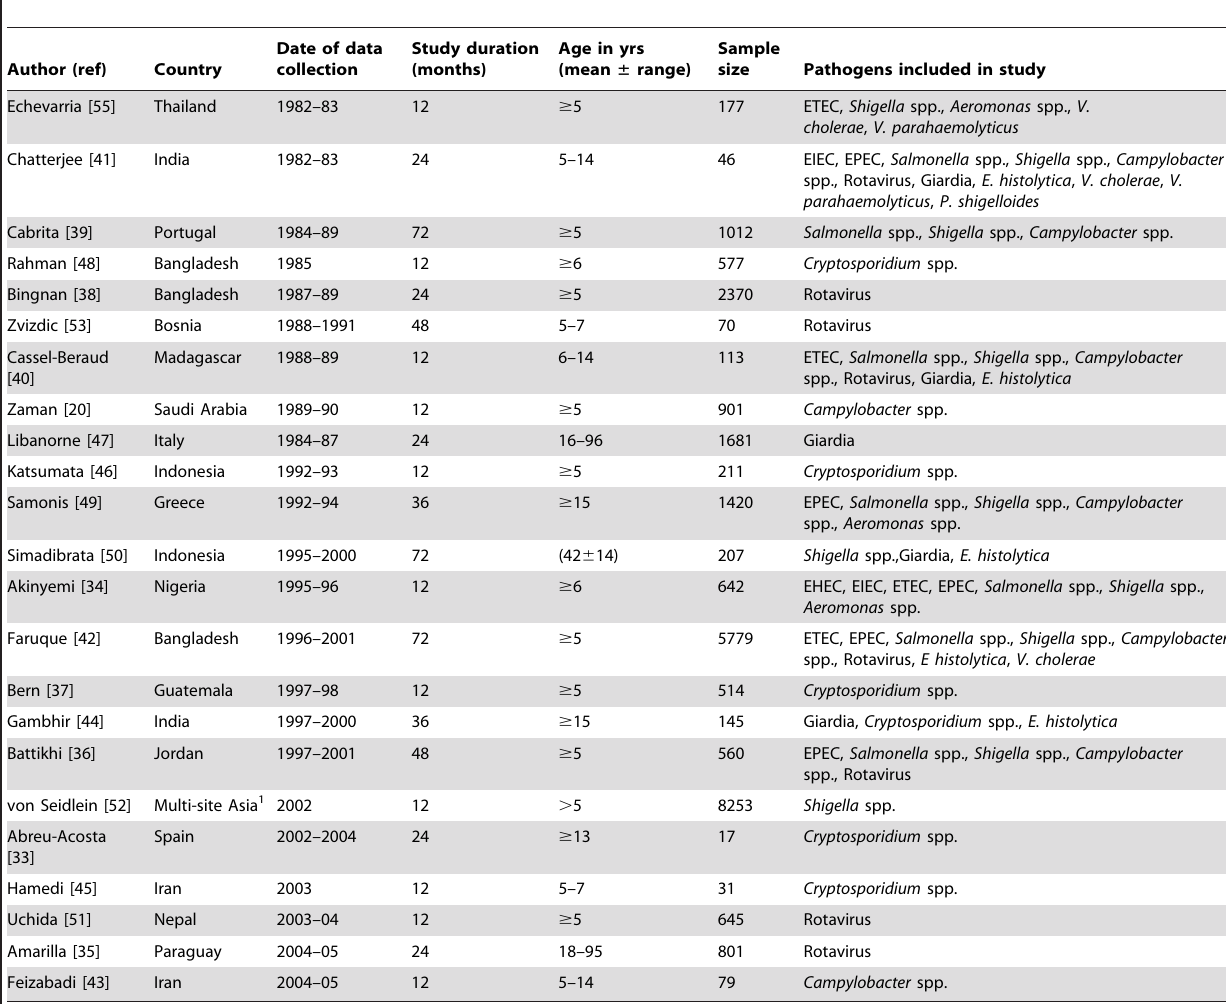
Table 3. Study characteristics of studies meeting inclusion criteria but excluded from final analysis because the study population (i.e. community-based, inpatient, or outpatient) was not given or results were not stratified by